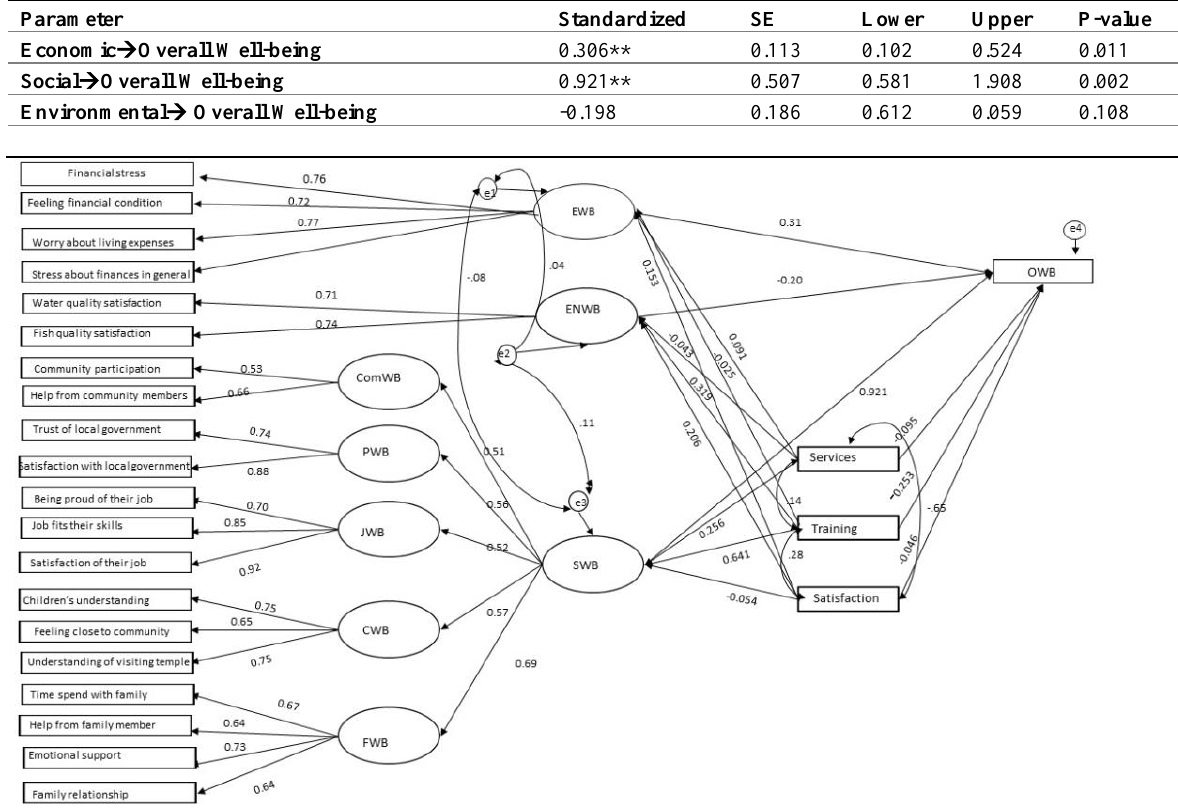
Table 7: Standardized Estimated Result of Three Pillar Well-Being Dimensions of SLF to Overall Well-Being.